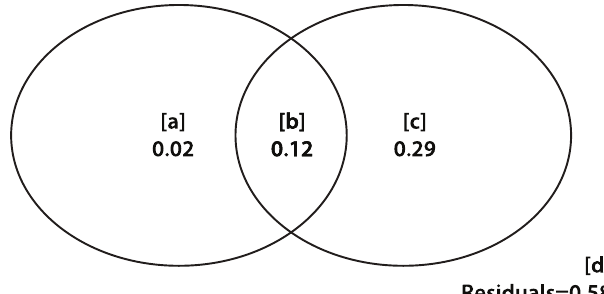
Figure 5. Variation partitioning for the Serra Sul vegetation data explained by two soil variable groups based on a partial Redundancy Analysis. Values shown are adjusted R 2 . The first soil group [ a ] comprises environmental variables P, K, Na, C, Pres, Al, and the second group [ c ] the variables soil depth and pH. Variation that is shared between two environmental variables groups is shown by [ b ], and the unexplained variance by [ d ]. Fractions were significant at p<0(005).